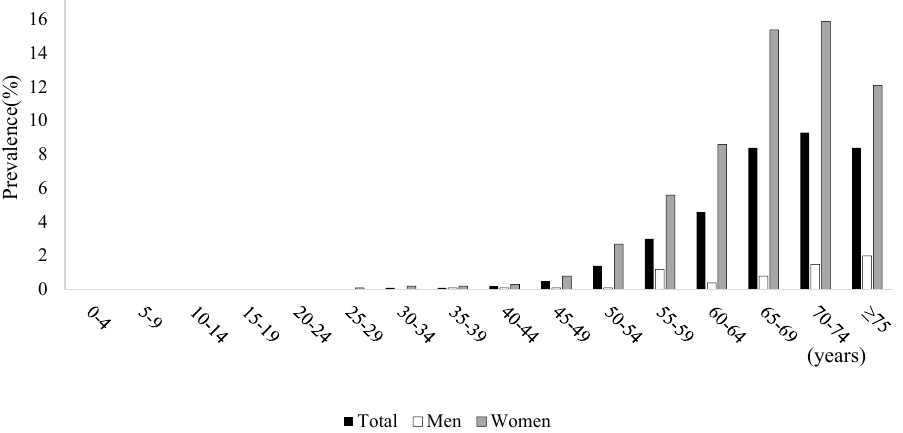
Figure 1. Prevalence based on principal diagnosis and economic burden of osteoporosis by sex and age.